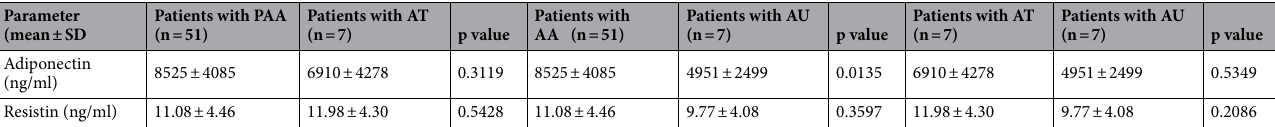
Table 3. Differences in the serum concentrations of adiponectin and resistin between patients with patchy alopecia areata, alopecia totalis and alopecia universalis. SD standard deviation, PAA patchy alopecia areata, AT alopecia totalis, AU alopecia